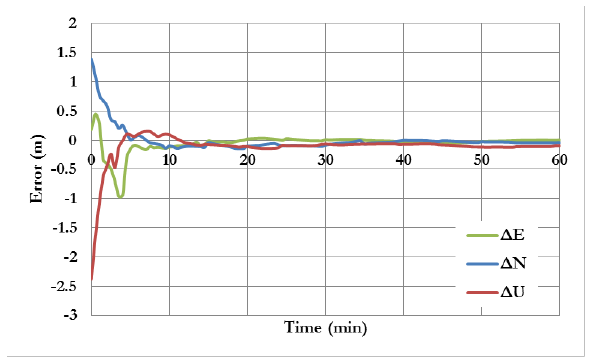
Figure 4: The positioning results of the GPS/BeiDou PPP model.